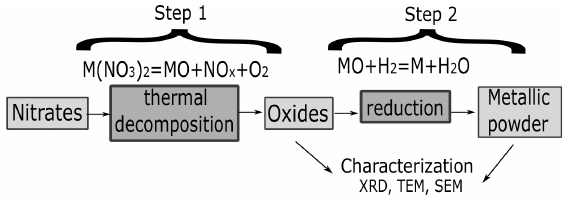
Figure 2. General schematic vision of the experimental